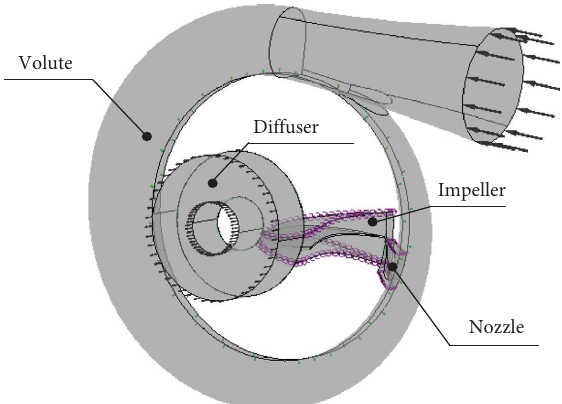
Figure 9: Runner model of the radial infow